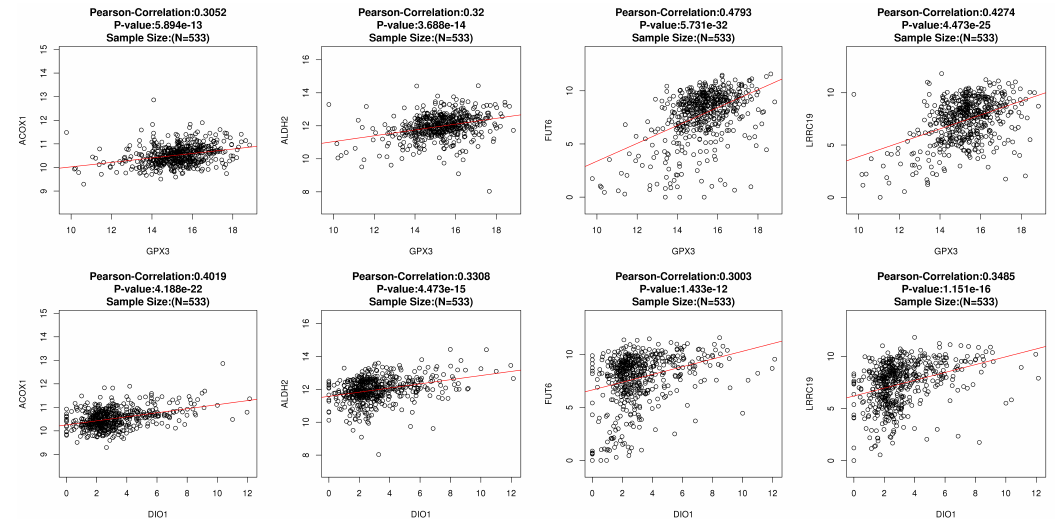
Figure A4. The correlation analysis of GPX3 and DIO1 was performed by the LinkFinder module of LinkedOmics. ACOX1, ALDH2, FUT6, and LRRC19 were the intersection genes generated from the GPX3 association results, DIO1 association results, and top 500 survival genes of KIRC. We used the Pearson Correlation test as the statistical method. Scatter plots showing associations with the four individual genes in detail. p < 0.01 and Pearson correlation coefficient R > 0.3 were considered as the two genes were statistically correlated in